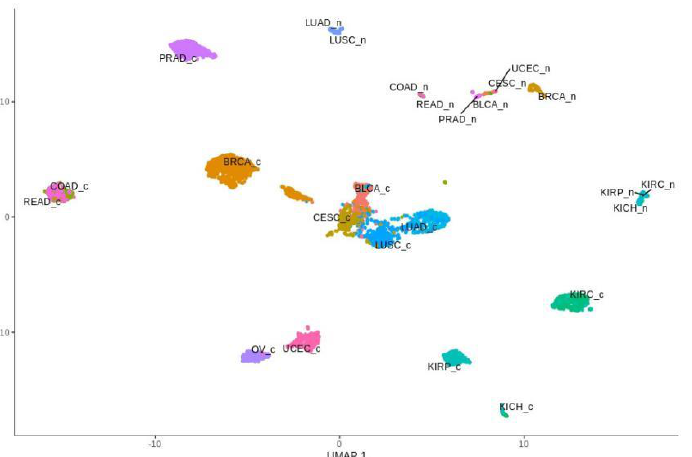
Figure 4. Spatial profiling of BLCA, BRCA, CESC, COAD, KICH, KIRC, KIRP, LUAD, LUSC, OV, PRAD, READ and UCEC, accompanied by normal tissue samples, with respect to expression of the Notch target genes. Tumors are designated with “c” endings, while normal tissues are designated with “n” endings.